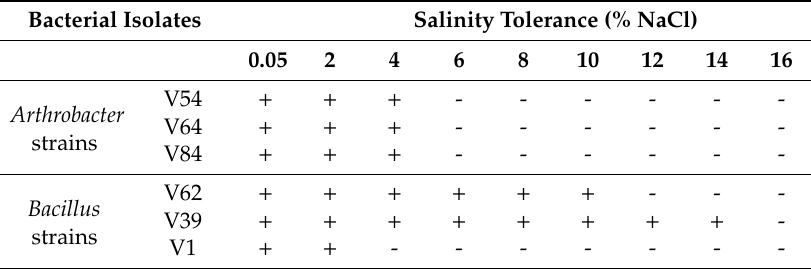
Table 1. Salt tolerance of di ff erent bacterial strains. Bacterial Isolates Salinity Tolerance (% NaCl)